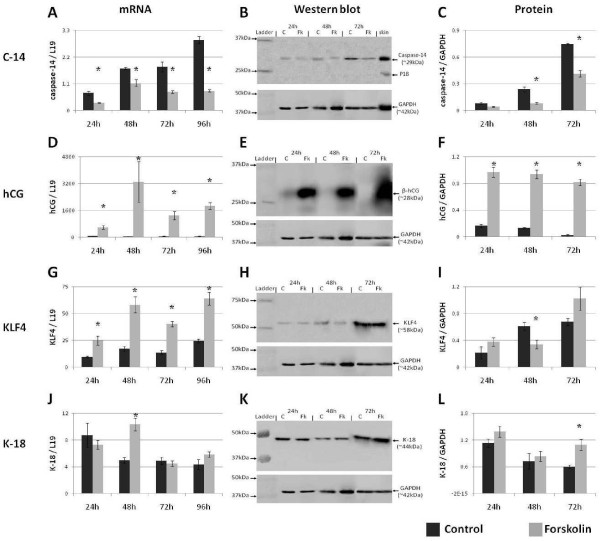
BeWo cell differentiation effects gene transcription. The effect of Forskolin treatment on BeWo cell expression of (A-C) caspase-14, (D-F) hCG, (G-I) KLF4 and (J-L) cytokeratin-18. * = P < 0.05 versus controls at the same time point.